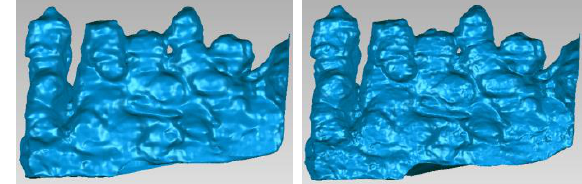
Figure 9. Point cloud from TLS (left) and SfM (right)